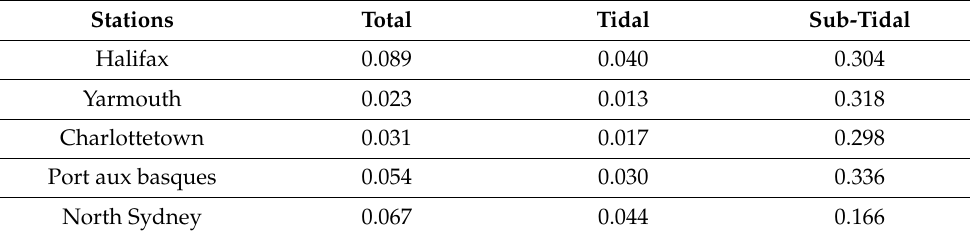
Table 2. List of γ 2 values for total, tidal, and sub-tidal surface